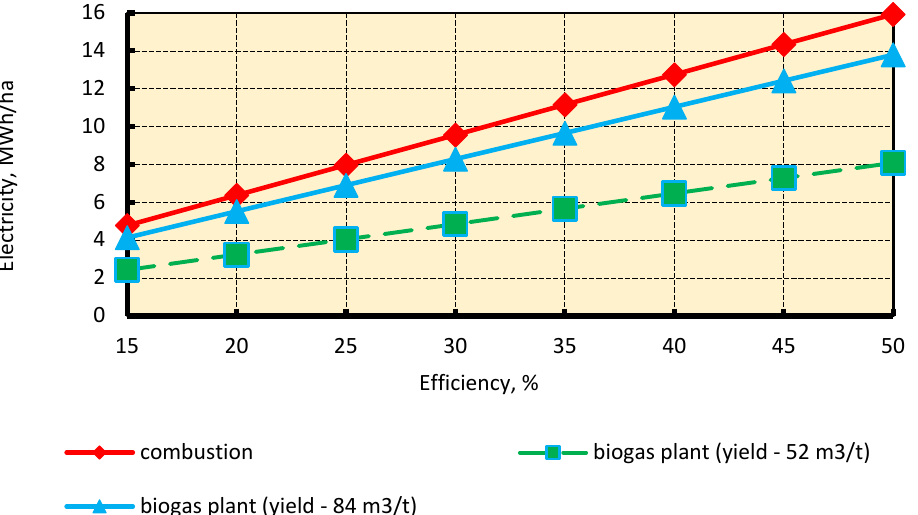
Figure 7. Power generated by sorghum-based power plant.